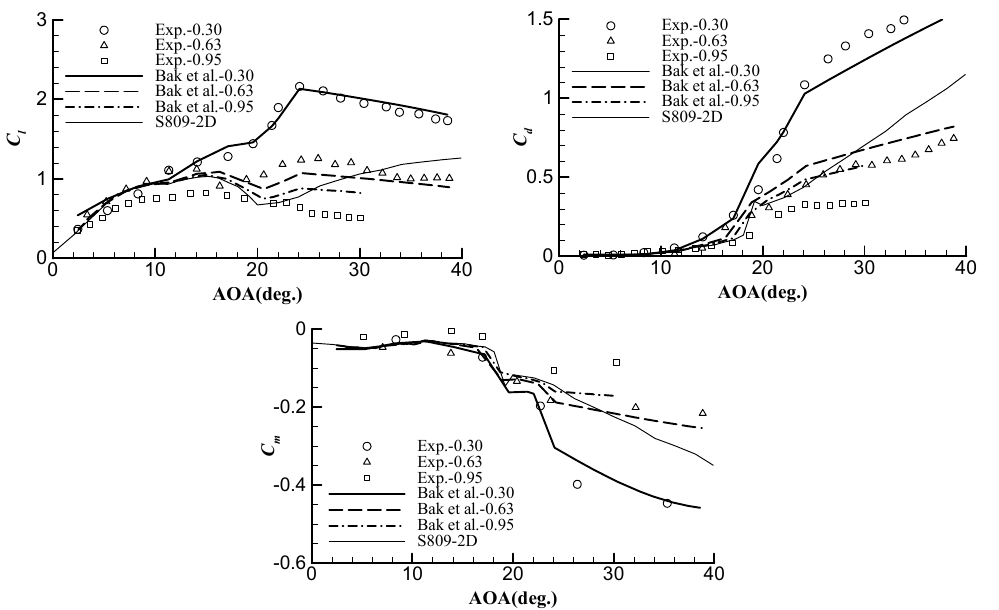
Figure 4. Three-dimensional (3D) corrected airfoil characteristics of different radial locations compared to two-dimensional (2D) measurements and measured 3D data.